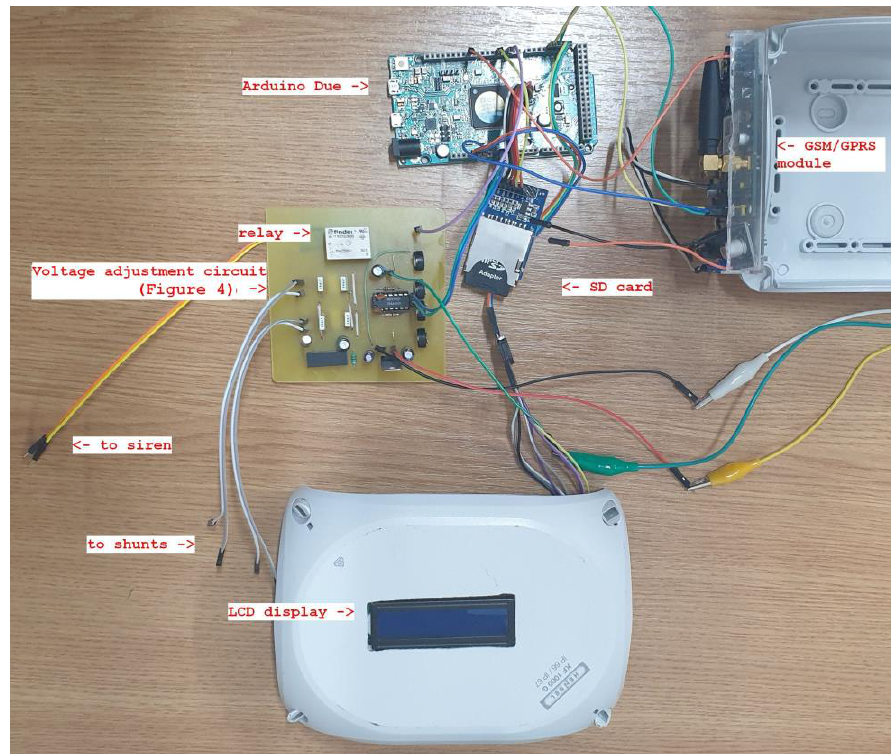
Figure 7. Prototype of DC motor overload detection system for excavator EKG-15.